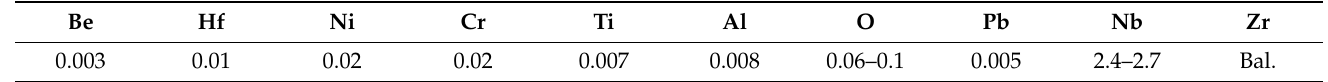
Table 1. Chemical composition of Zr2.5Nb —wt%.